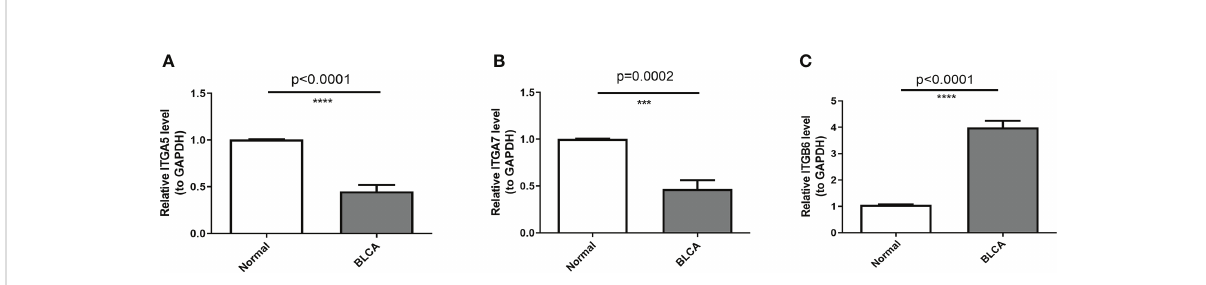
FIGURE 7 Exprerimental validation of ITGA5, ITGA7, and ITGB6. (A) Relative mRNA expression of ITGA5 in BLAC tissue and paracancerous tissues. (B) The mRNA expression level of ITGA7 in mRNA expression levels of prognostic genes in BLCA clinical samples. (C) The mRNA expression level of ITGB6 in mRNA expression levels of prognostic genes in BLCA clinical samples ***P < 0.001,****P <